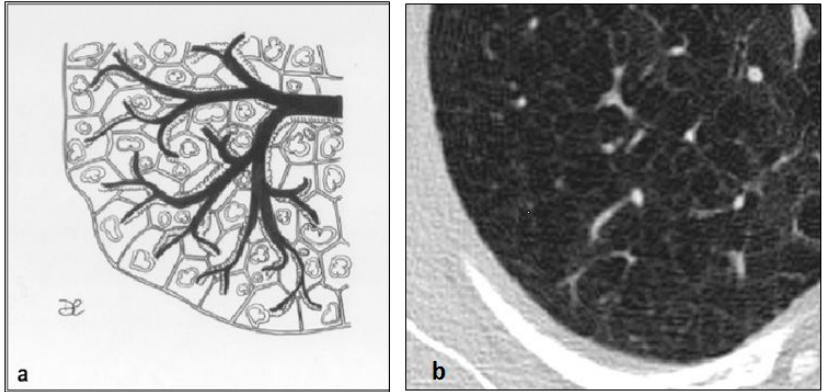
Figure 2. LCH cystic pattern ( a ). Lung cysts, ranging from 10 to 20 millimeters of diameter, are depicted in figures ( a ) and ( b ). These cysts show thick walls and bizarre shape. Diagnostics 2020 , 10 , x FOR PEER REVIEW